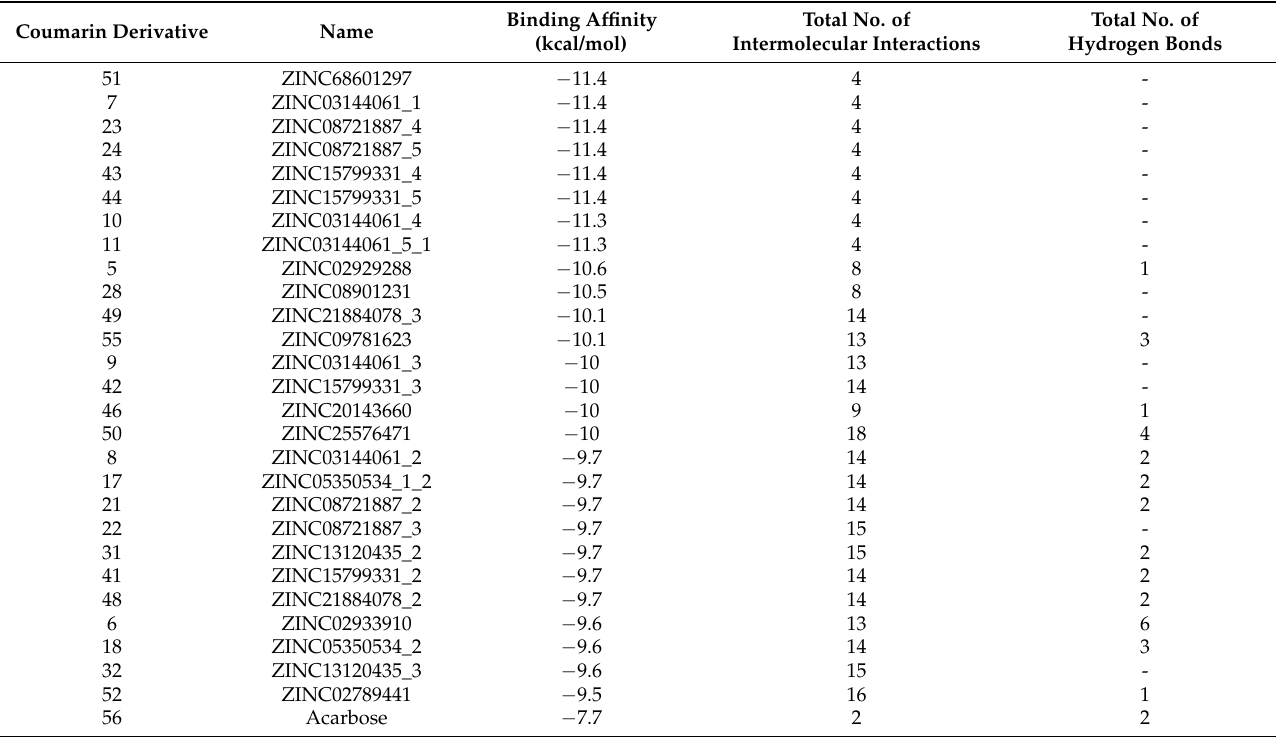
Table 6. Virtual screening of selected coumarin derivatives from pharmacophore studies for α -amylase.